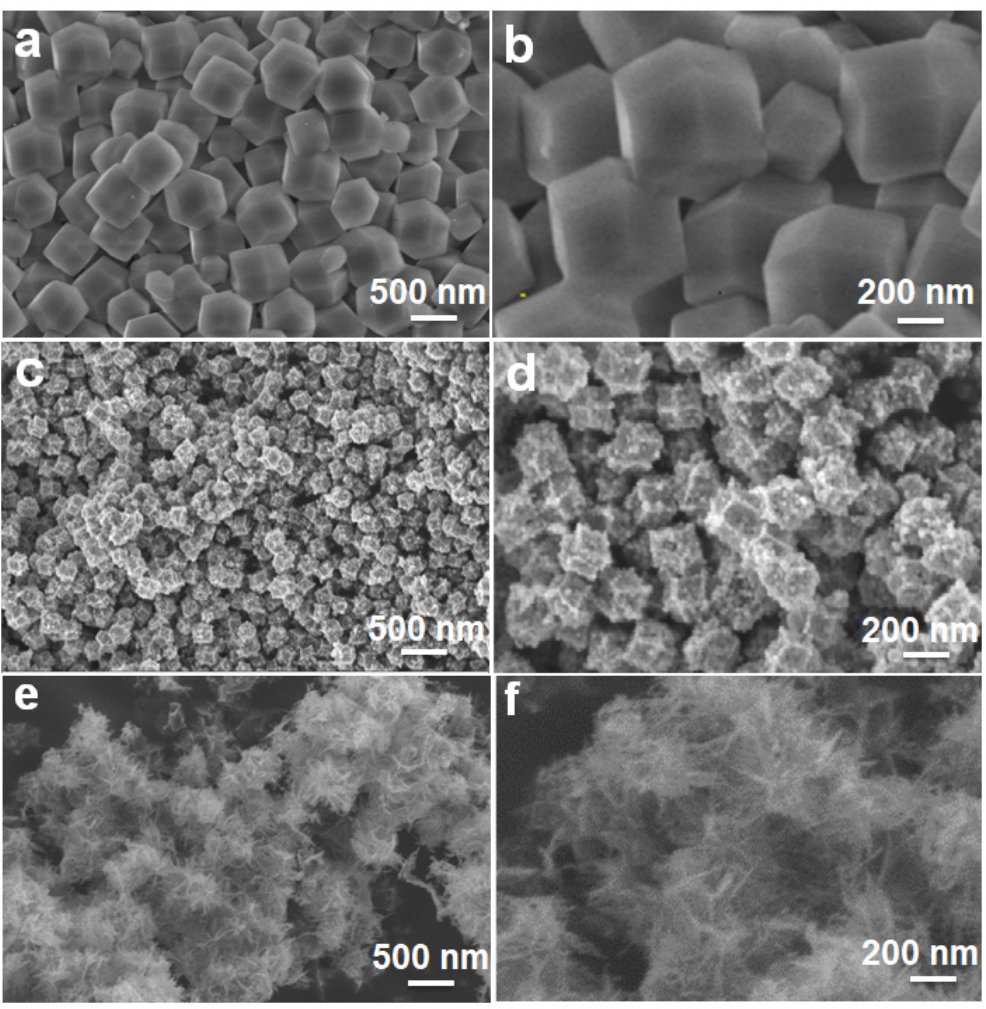
Figure 3. FESEM images of ( a , b ) ZIF-8, ( c , d ) ZnO and ( e , f ) ZnO/Fe 2 O 3 NFs.